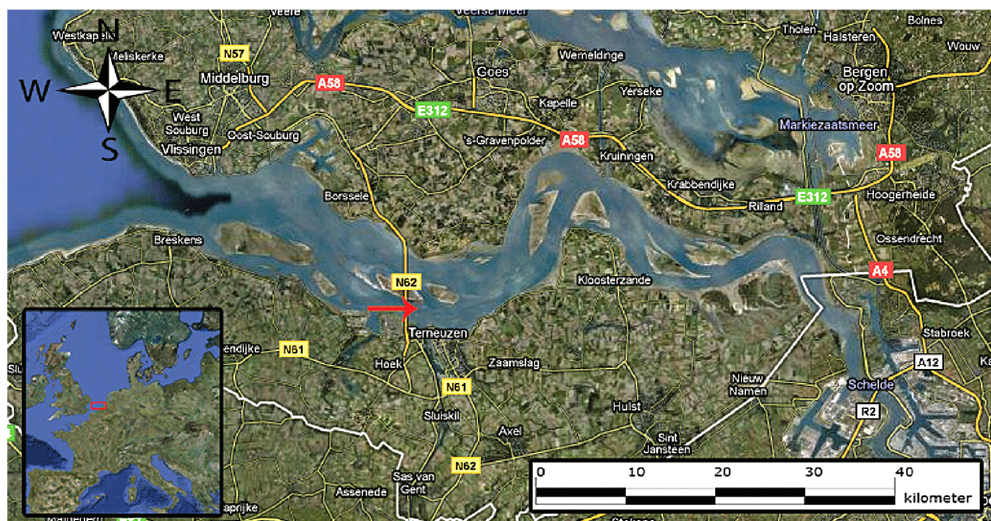
Figure 1. Overview of the Westerscheldt Estuary, the small map in the left corner indicates the location of Westerscheldt Estuary in western Europe with a red rectangle. The complexity of this alluvial estuary is shown on this aerial photograph. The position of buoy 18 is indicated by a red arrow, near the town of Terneuzen. The area shown measures 60 by 40km. Image is taken from Google